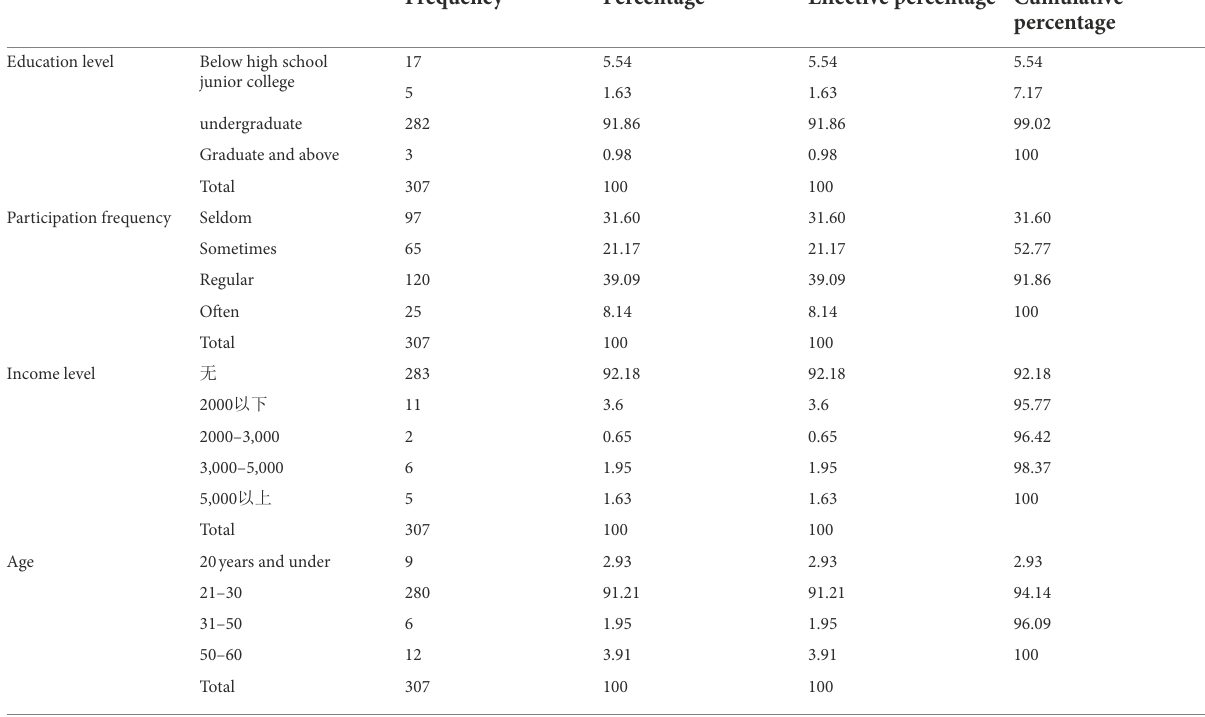
TABLE 1 Descriptive statistical